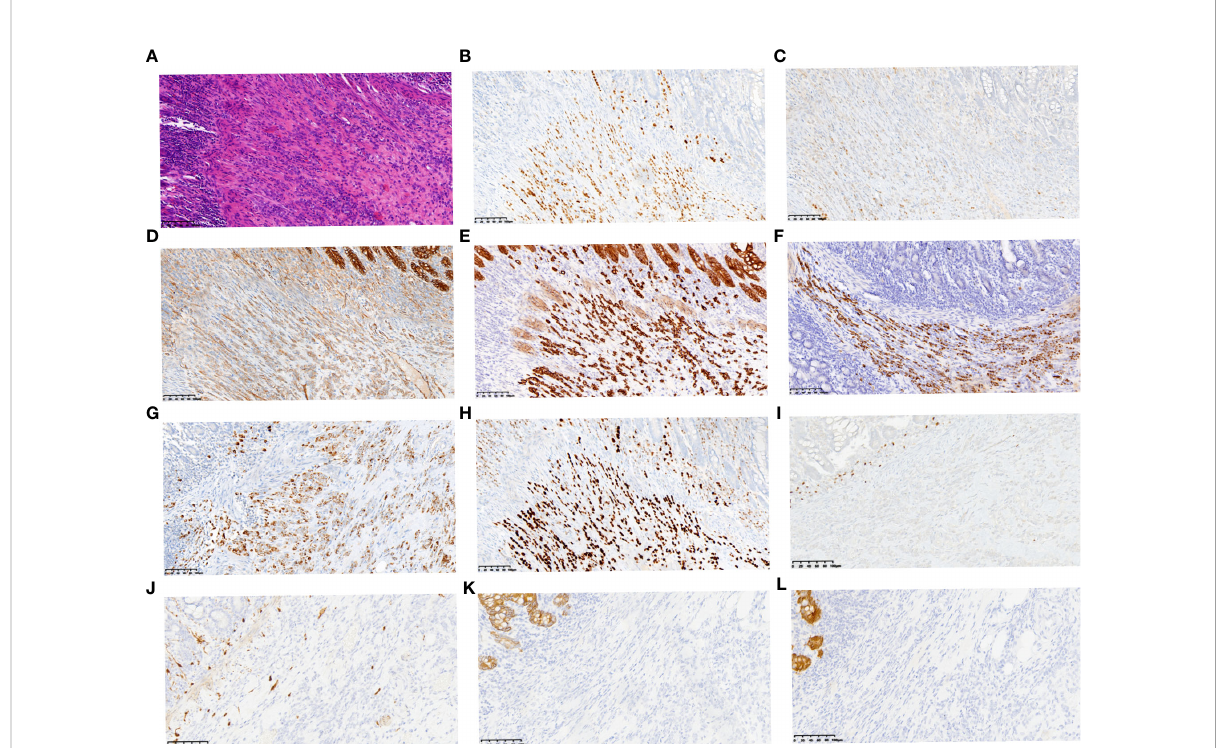
FIGURE 1 Representative histopathological results of small intestine metastasis. Small intestine metastasis was found to be diffuse in fi ltrating the submucosal muscularis propria and serosa (A) (HE staining, ×200, scale bars: 200 µm). Immunohistochemical staining revealed positive expression of ER (B) and PR (C) . Besides, p120 catenin was cytoplasmically positive (D) . CK (E) , CK7 (F) , Mammaglobin (G) and GATA3 (H) were all found to be strongly positive, while PAX8 (I) , S100 (J) , CK20 (K) and Villin (L) were weakly expressed or negative. (immunohistochemical staining, ×200, scale bars: 200 µm).